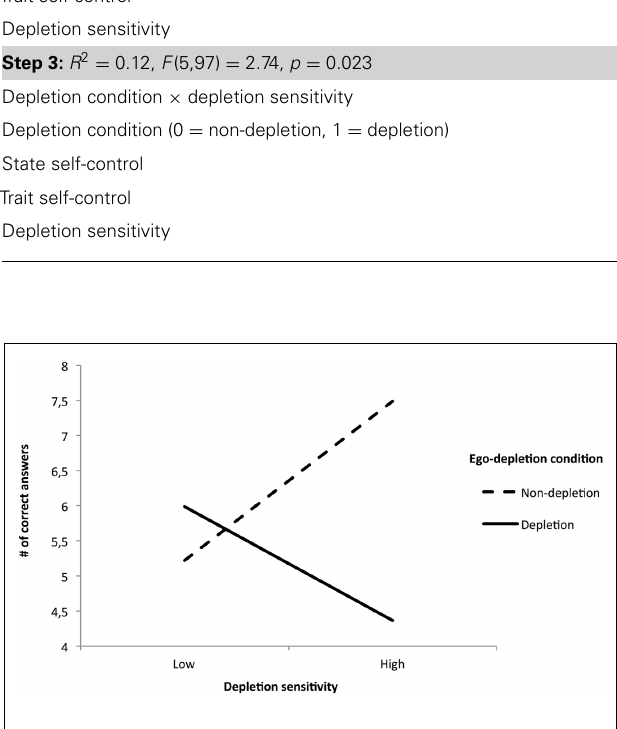
FIGURE 1 |The interaction between depletion sensitivity and ego-depletion condition on cognitive task performance, Study 3.